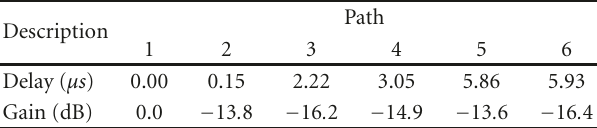
Table 1: “Brazil A” channel multipath profile. Description